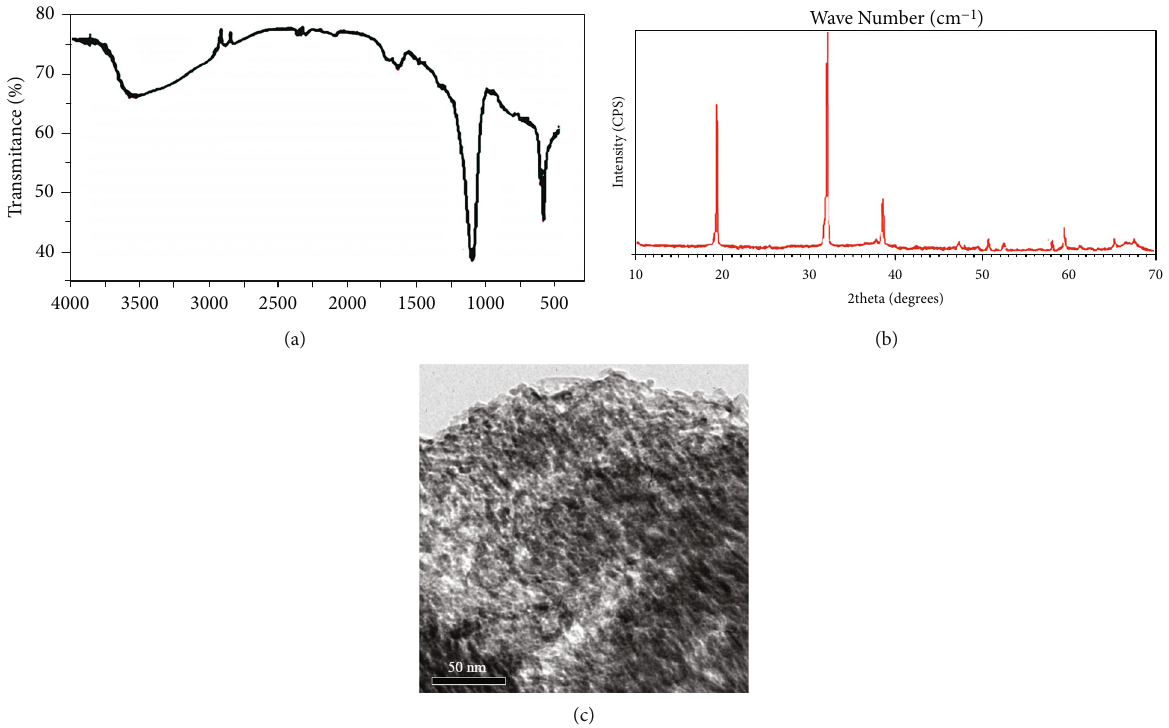
Figure 1: The characterization of the aluminum oxide nanoparticle adsorbent material using (a) the X-ray di ff raction pattern, (b) Fourier- transform infrared spectroscopy, and (c) transmission electron microscopy image.